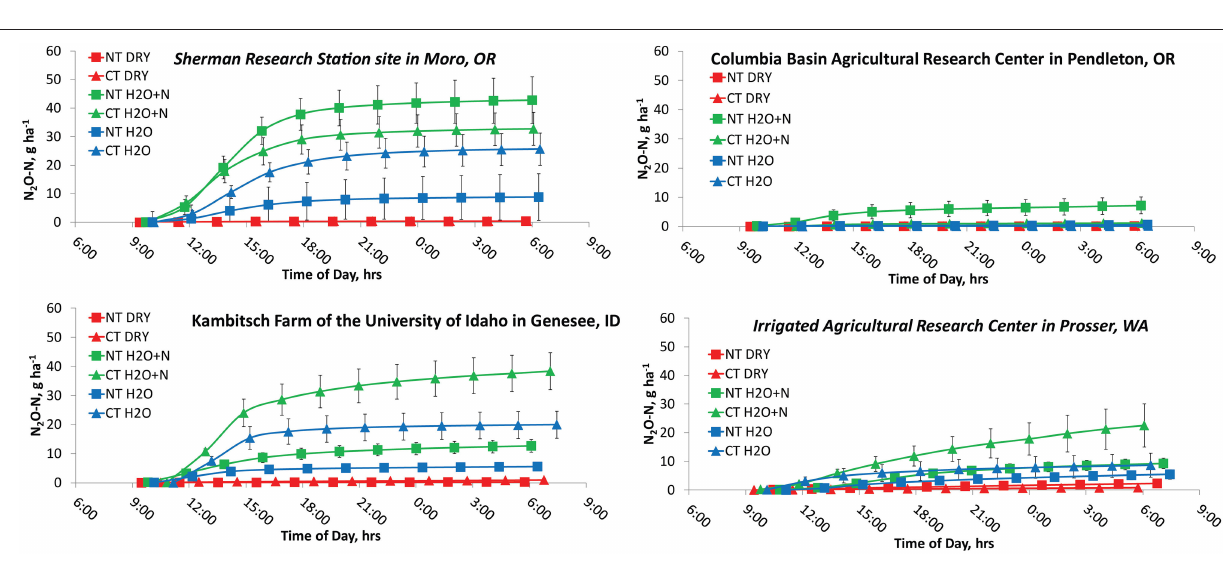
FIGURE 4 | Cumulative emissions of N 2 O during the first day (0–22h) of measurements with and without additions of 150kg N ha − 1 and water to no-tillage and conventional tillage management